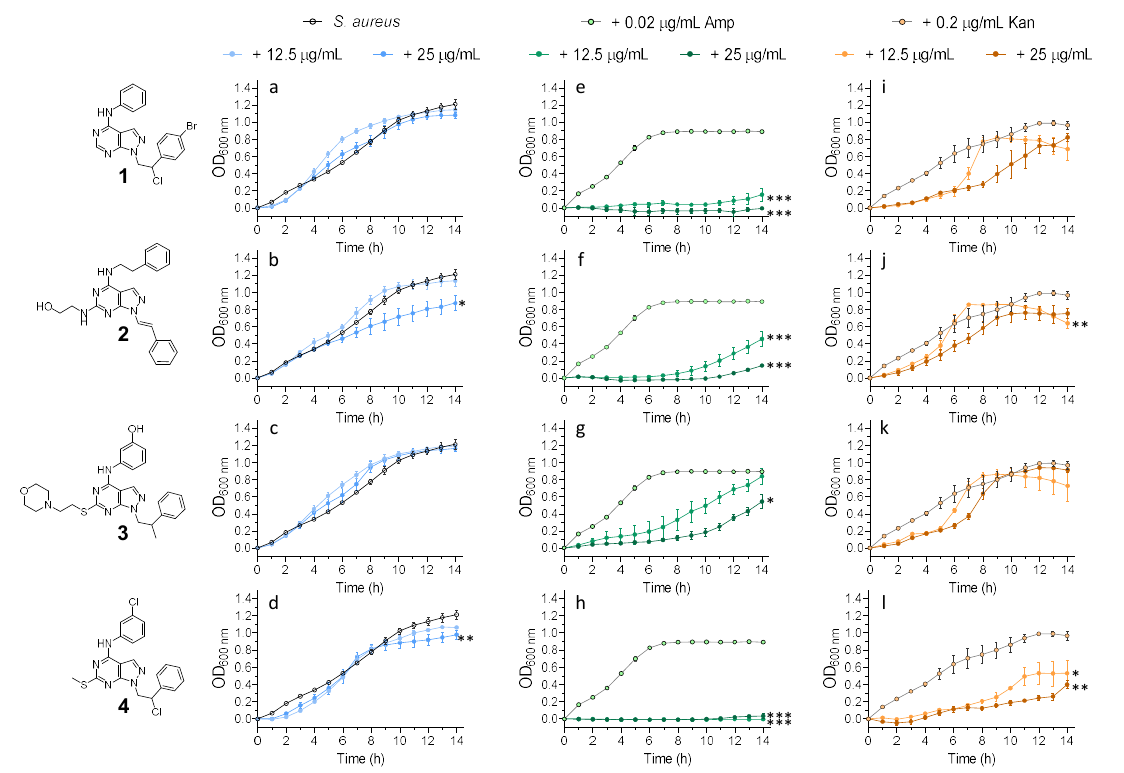
Figure 5. Growth curves of S. aureus grown in the presence of ( a – d ) pyrazolo[3,4- d ]pyrimidines (12.5 and 25 µ g / mL), ( e – h ) pyrazolo[3,4- d ]pyrimidines (12.5 and 25 µ g / mL) in the presence of a sublethal dose of ampicillin (0.02 µ g / mL) and ( i – l ) pyrazolo[3,4- d ]pyrimidines (12.5 and 25 µ g / mL) in the presence of a sublethal dose of kanamycin (0.2 µ g / mL). Amp = ampicillin and Kan = kanamycin. Data are representative of at least 3 independent repeat experiments. Error bars indicate SEM. p -values of significance (* < 0.05, ** < 0.01 and *** < 0.001) were determined using one-way analysis of variance (ANOVA). OD: optical density.